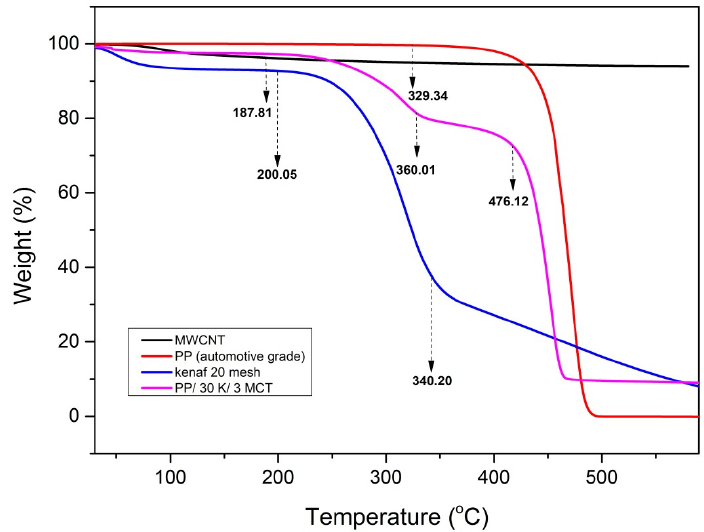
Figure 1. Thermogravimetric analysis (TGA) analyses of kenaf, PP, MWCNTs, and PP/kenaf/MWCNT hybrid composites .